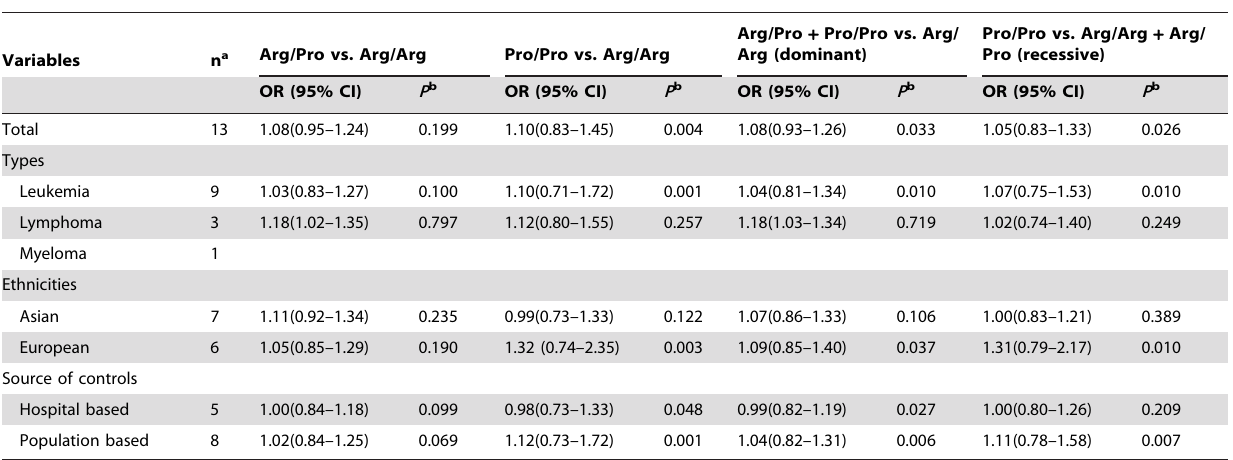
Table 2. Meta-analysis of the p53 codon 72 Arg . Pro polymorphism on hematological malignancy risk.